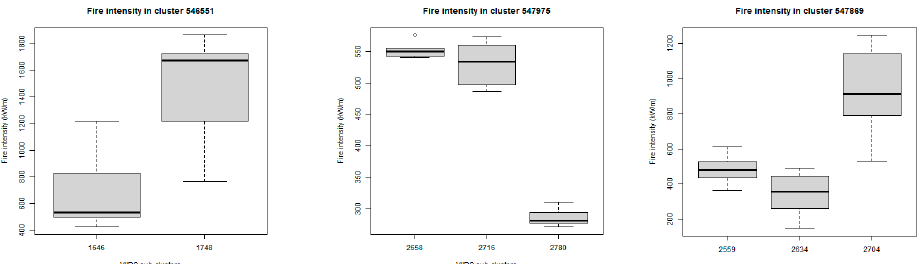
Figure 7. Boxplots of FI for VIIRS fire clusters that could visually be associated with head fires and flanking fires ( left and right panel) and head and backing fires ( middle panel). The fire clusters correspond to those depicted in Figure 2 ff (in the same left-to-right order). The numbers of the VIIRS subclusters on the x-axis correspond to the numbers on or near these clusters in Figure